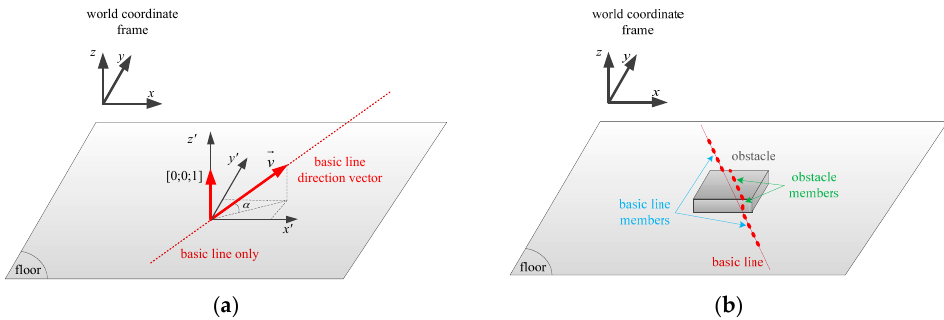
Figure 6. Laser points’ contribution. ( a ) Floor or wall case: only a basic line exists; ( b ) Obstacle case: the laser stripe contains an obstacle and basic line members.